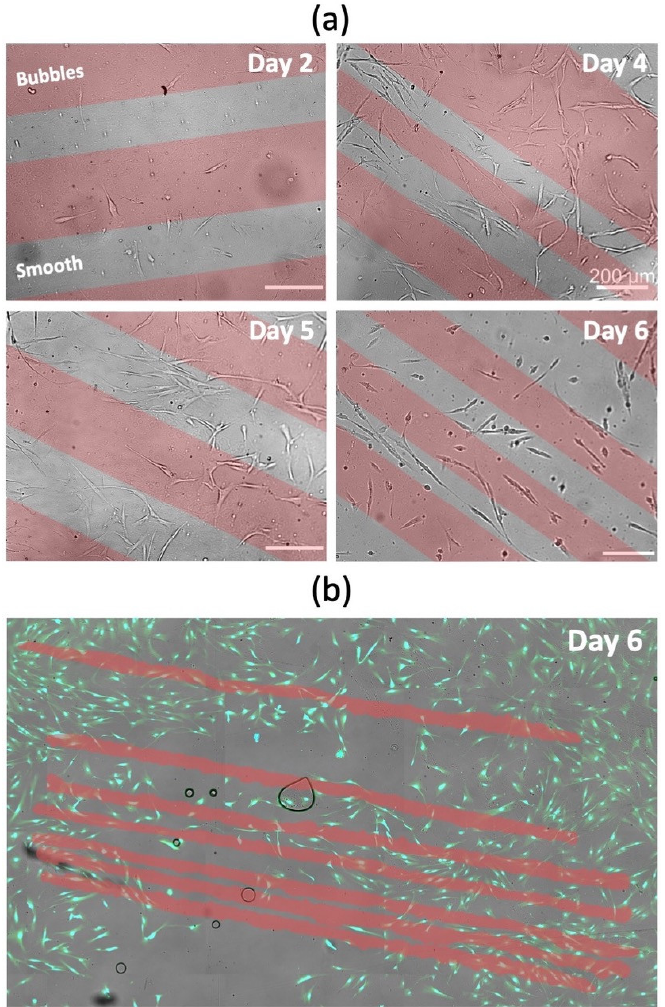
Figure 6. Fibroblasts cultured on PLA films with foamed patterns. ( a ) Bright-field micrographs of the cells growing on the surfaces, over time. ( b ) Image of a phalloidin/DAPI-stained sample, at day 6. Foamed lines are shadowed in red.